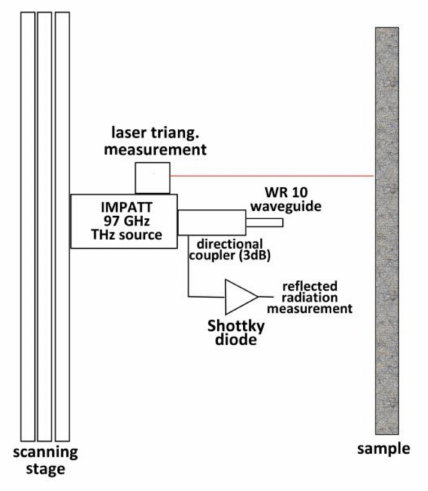
Figure 15. Layout of the new imaging